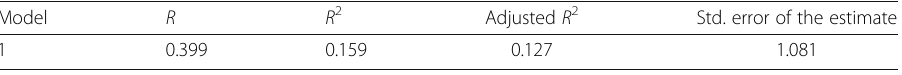
Table 6 Model summary for the language proficiency subskills as predictors of depersonalization Model